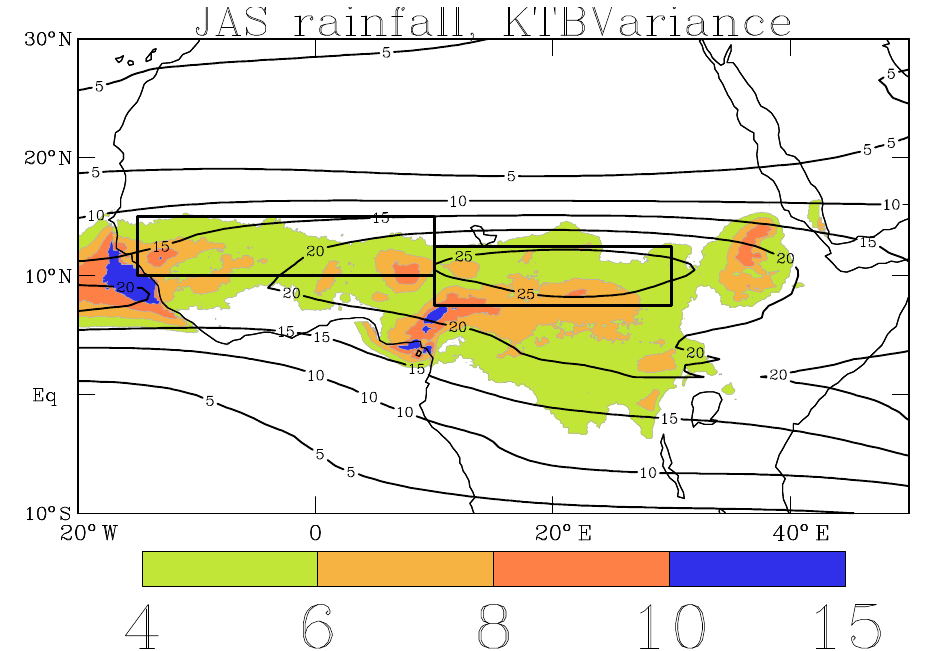
Figure 1. July–September (JAS) mean rainfall (mm d − 1 ; shaded as shown in the legend; 1984 to 2012) and Kelvin wave filtered T B variance (K 2 ; contoured every 5K 2 starting from 5K 2 ; 1984 to 2008). The two boxes in the figure are the averaging domains for the year-to-year variability of West and Central African rainfall shown in Figure 2. KTBvariance stands for Kelvin wave filtered T B variance: